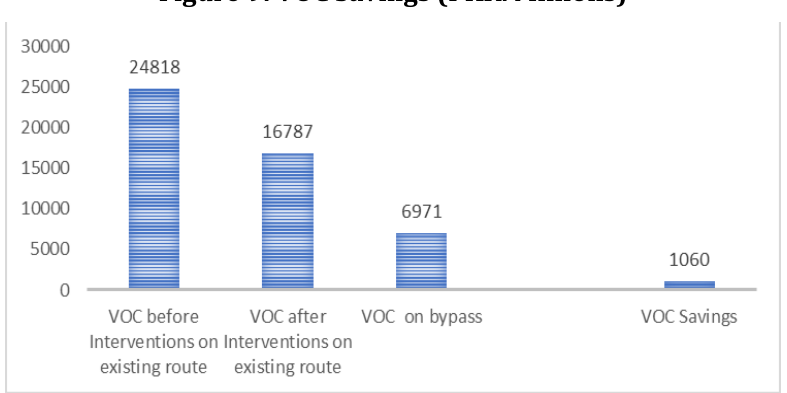
Figure 9: VOC Savings (PKR. Millions)